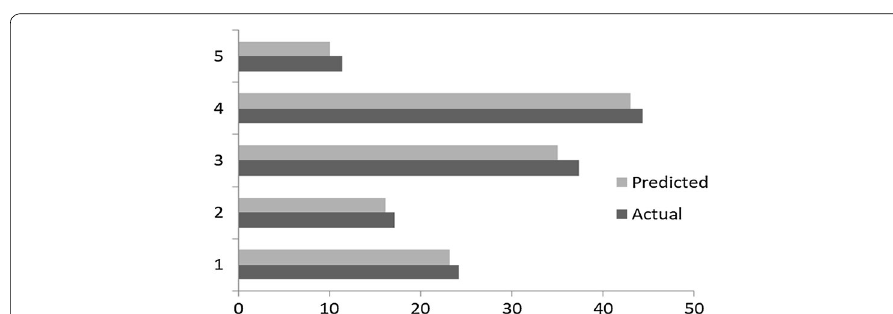
Fig. 4 Actual values of total_UPDRS compared to predicted values